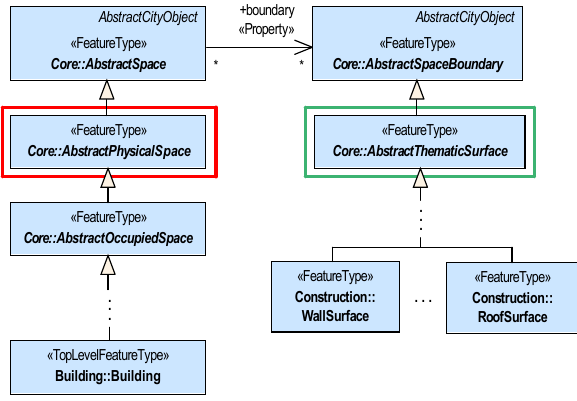
Figure 2. Classification of Building elements based on the CityGML 3.0 Space concept. Classes not relevant for illustrating the classification hierarchy are omitted. The prefixes before :: denote the modules in which the concepts are defined.